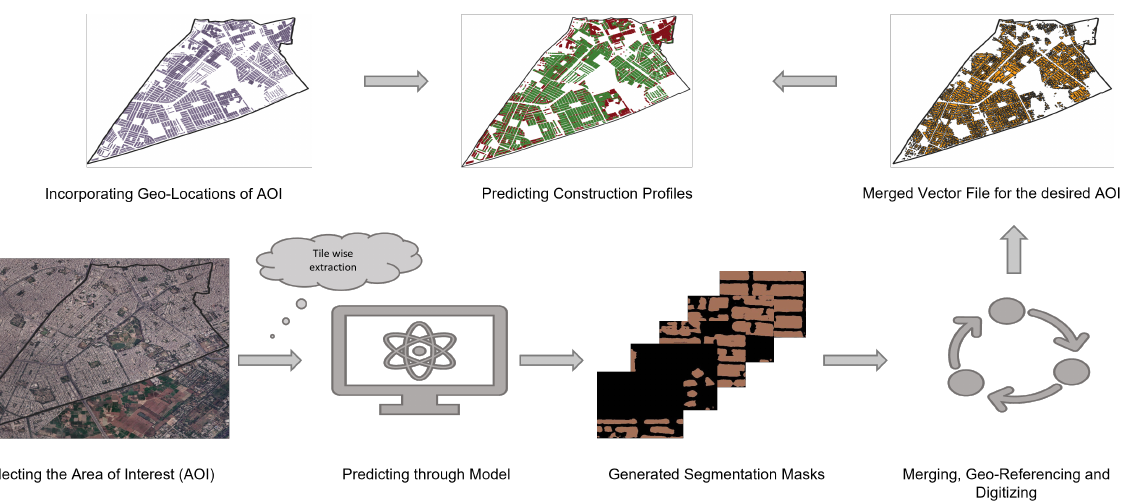
Figure 5. The Proposed Pipeline. The first step is the selection of AOI and providing its satellite image to the trained model through tiling. After that, the generated masks are merged, geo-referenced, and digitized into a vector file. In the end, the vectorized file is overlaid with the extracted geo-locations for that AOI, and profiles are developed. The green dots in the final image represent the construction of that specific building, while the red dots show that they weren’t